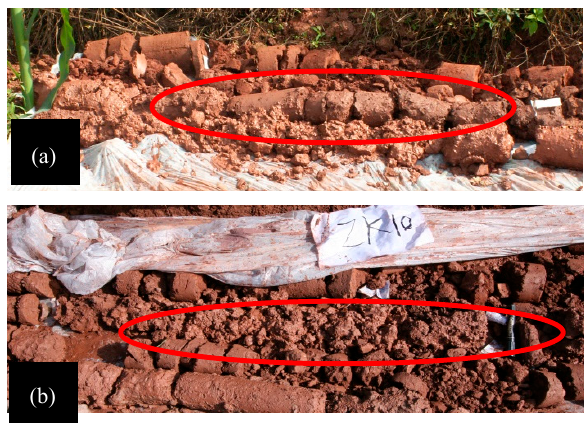
Figure 13. Mud softening phenomenon.